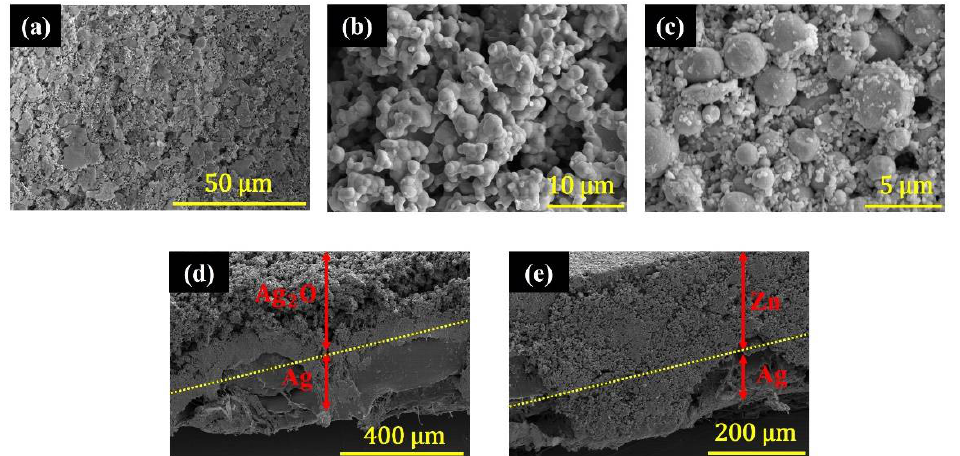
Figure 3. Top surface of the ( a ) silver current collector; ( b ) silver oxide electrode; and ( c ) zinc electrode. Cross-sectional SEM image of the ( d ) silver oxide electrode; and ( e ) zinc electrode.